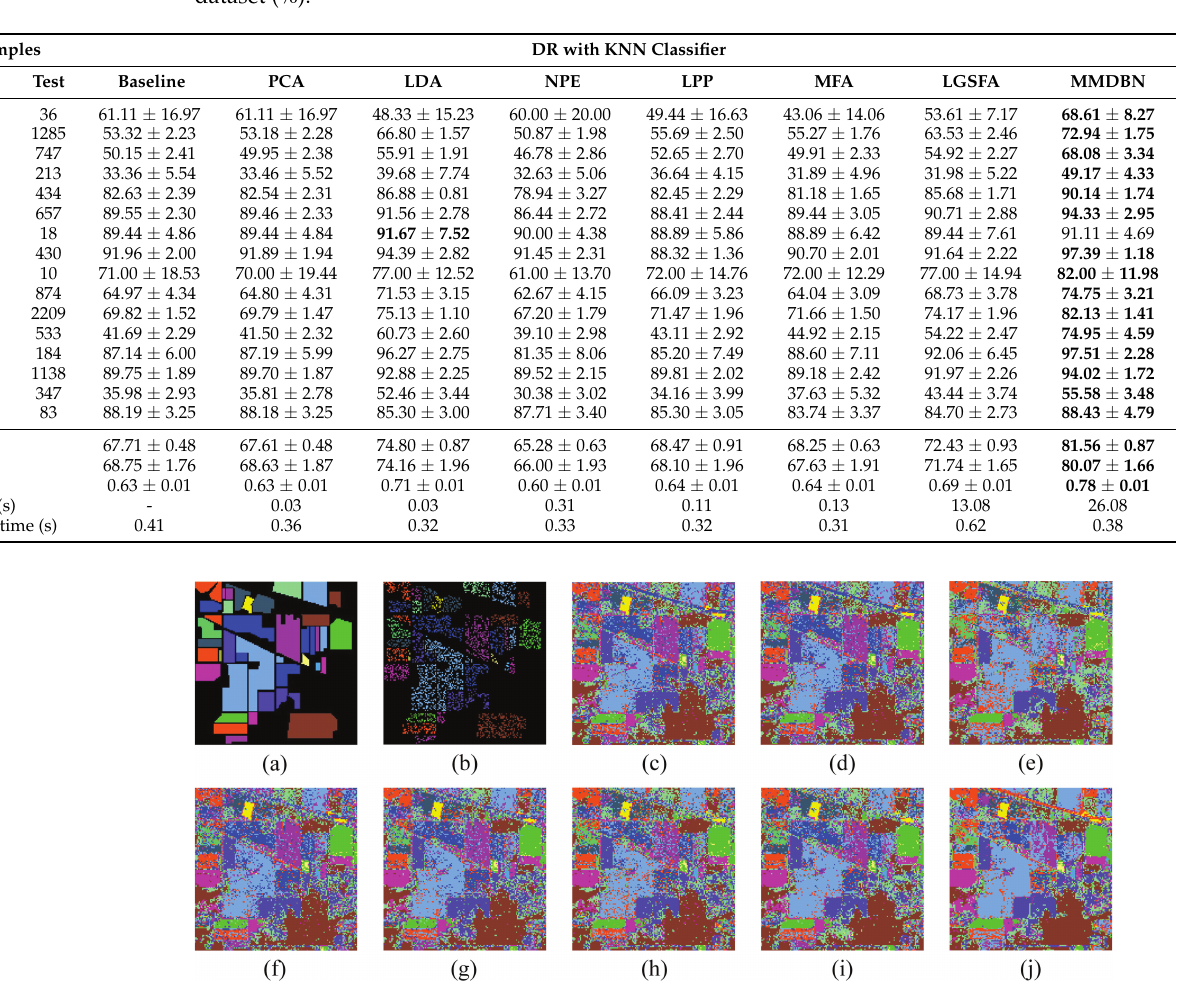
Table 4. Classification results of each class samples via different DR methods for Indian Pines dataset (%).